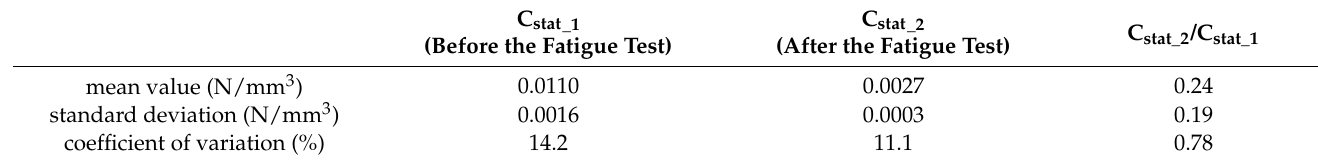
Table 4. Experimental results of the static bedding modulus C stat for Mat B.